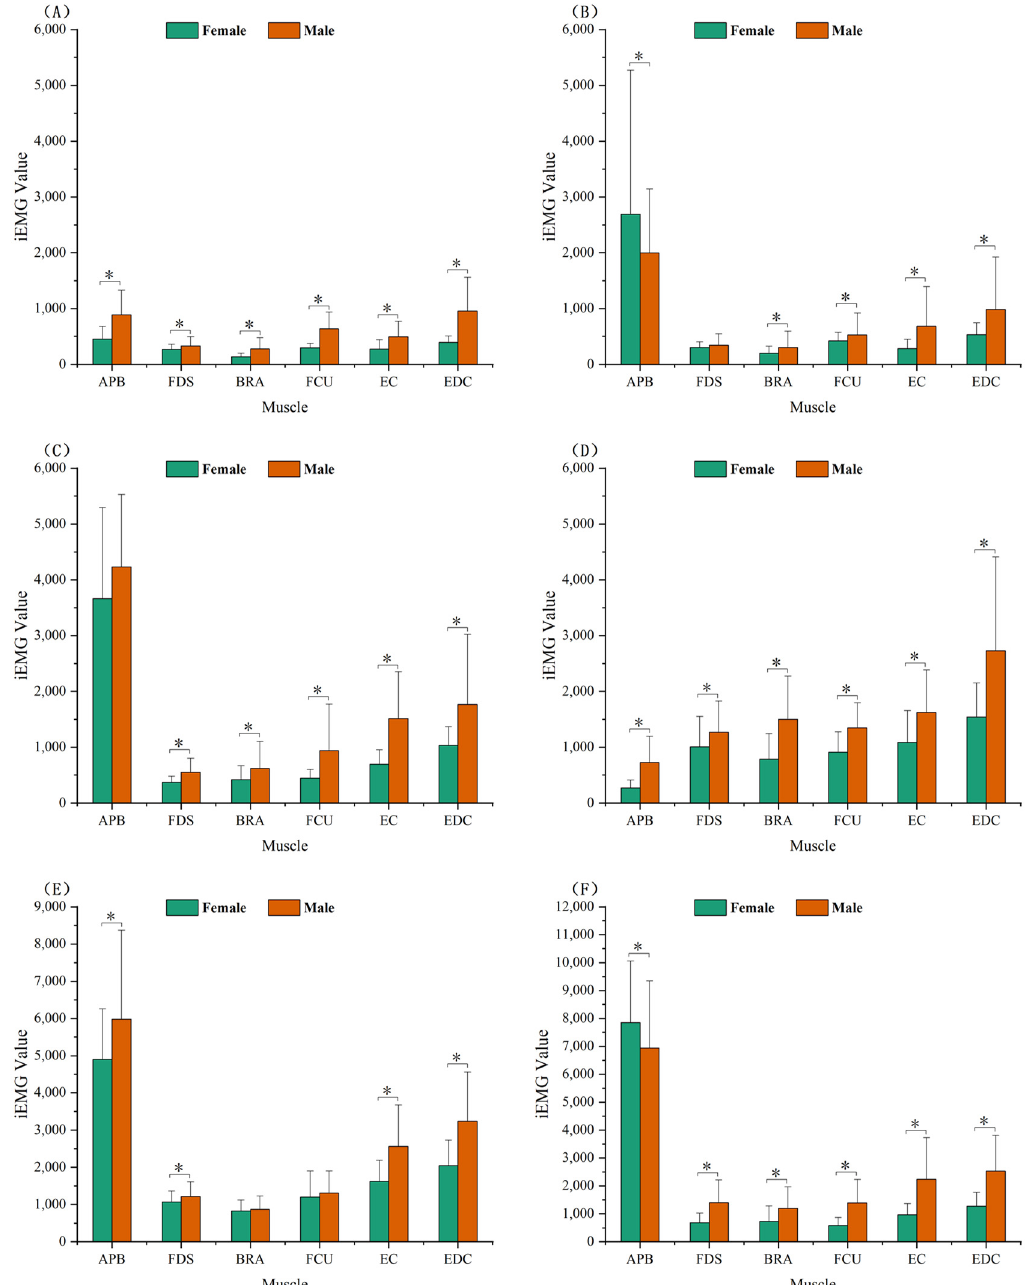
Figure 2. The statistical analysis results of iEMG values for six hand movements of the same muscle pair in the right hand of female and male. ( A ) RM; ( B ) TB; ( C ) TI; ( D ) FF; ( E ) HC; ( F ) FK. (*) represents p <0.05 between the right hand of the female and male. Error bars represent standard error. Table 7. Tests of between-subject effects (dependent variable: iEMG value).